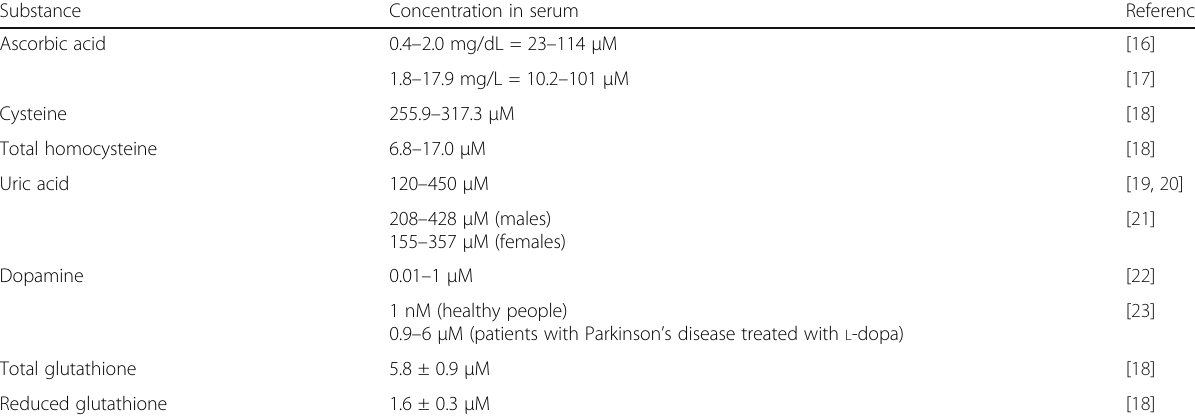
Table 1 Concentration of electroactive substances in human blood serum